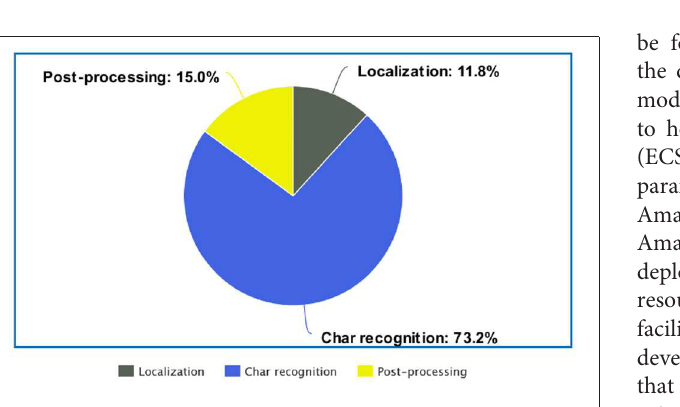
FIGURE 10 | Detailed error analysis by